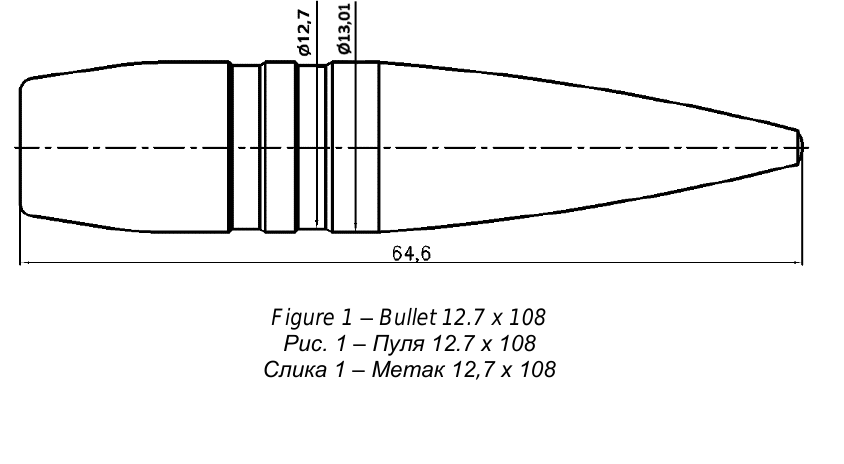
Figure 1 – Bullet 12.7 x 108 Рис. 1 – Пуля 12.7 х 108